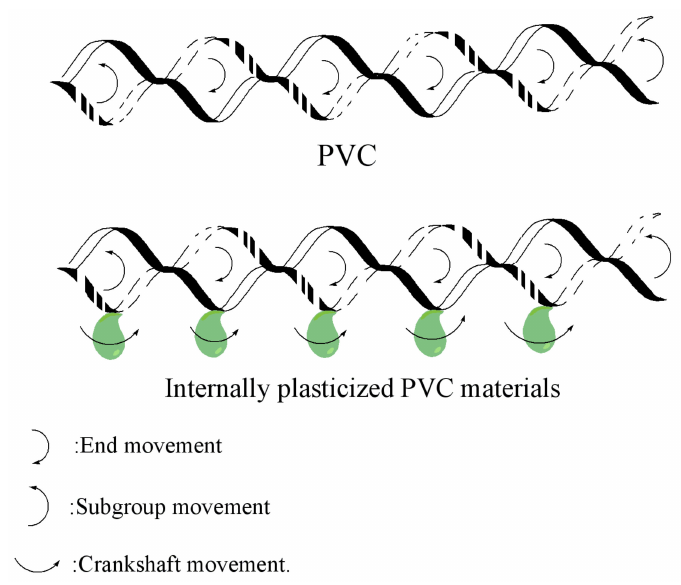
Figure 8. Three kinds of movement for chain-like macromolecules in free volume theory.